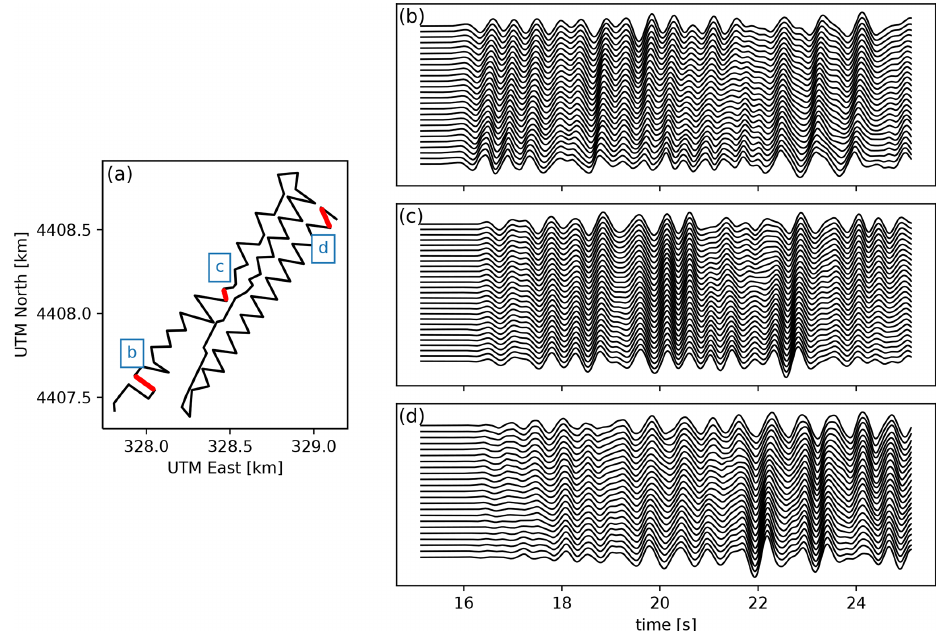
Figure 10. Location of the selected DAS cable segments, indicated in red in panel (a) . The corresponding P waveforms that are shown in panels (b) , (c) , and (d) are filtered in a 0.5–2Hz pass band and scaled by the standard deviation of each trace.